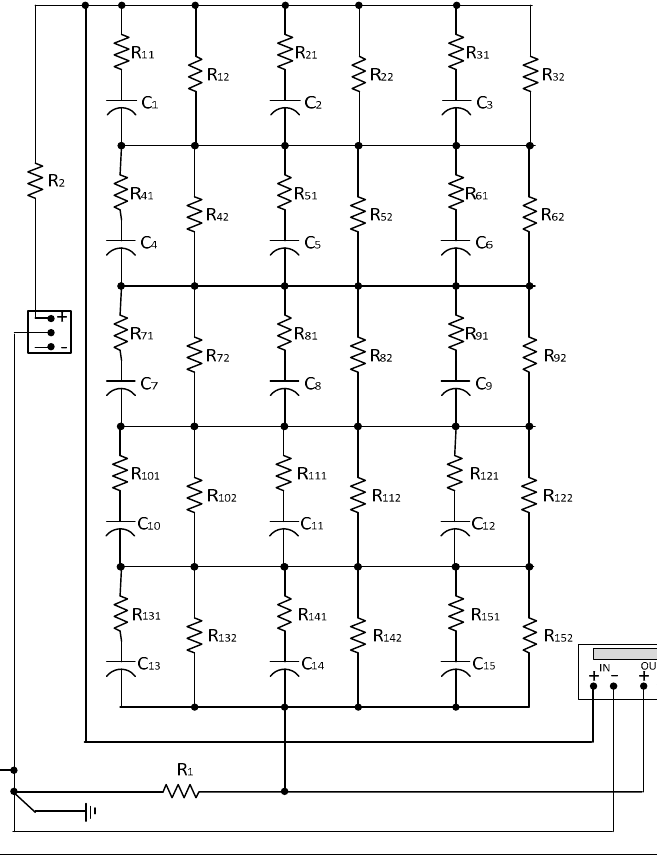
Figure 3. The equivalent bushing model used for simulations [11].